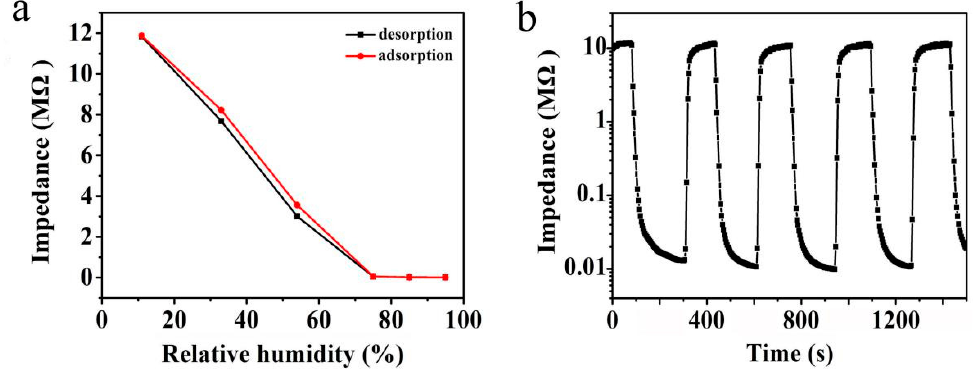
Figure 7. ( a ) Humidity hysteresis curve of Mg-doped ZnO microspheres, ( b ) response and recovery characteristic curve of Mg-doped ZnO microspheres (1.5 mol%).